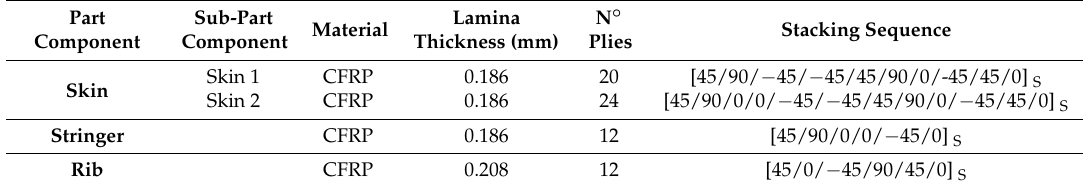
Figure 2. ( a ) CFRP multi stringer multi-stringer component’s geometry and ( b ) and artificial damage geometry. Table 3. Part components for multi-stringer element